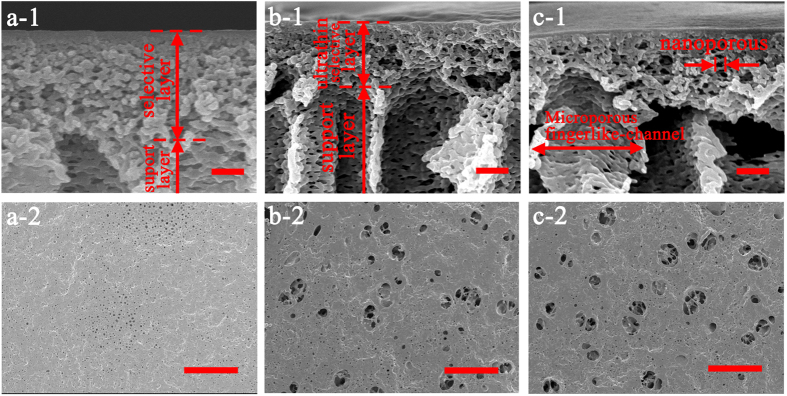
The structure of membrane cross-section and bottom surface.(a) P membrane, (b) GO-P membrane, (c) GO-P-S membrane. (a-1~c-1) Enlarged FESEM images of membrane cross-section, scale bar 300 nm. (a-2~c-2) FESEM images of membrane bottom surface, scale bar 10 μm.